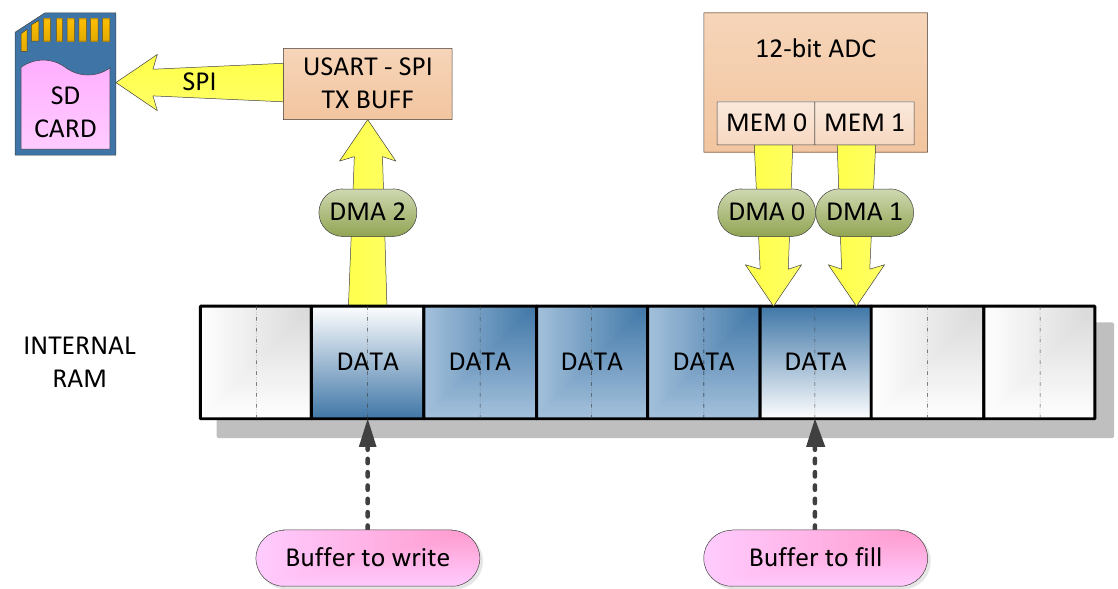
Figure 4. Modules involved in data writing. Example of internal data